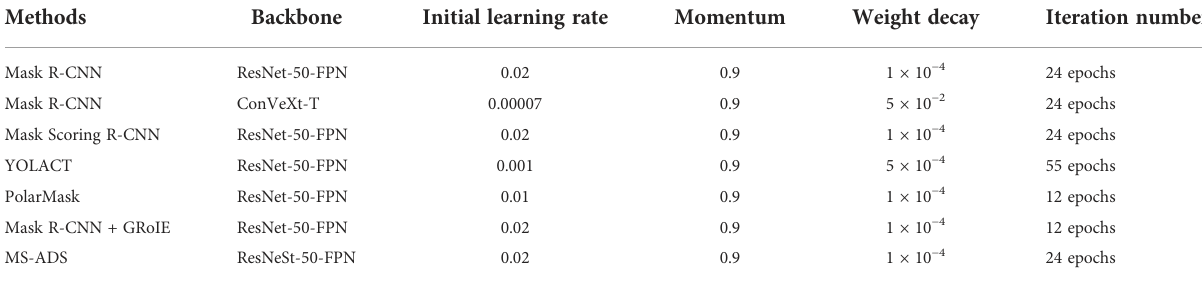
TABLE 4 Con fi gurations of seven